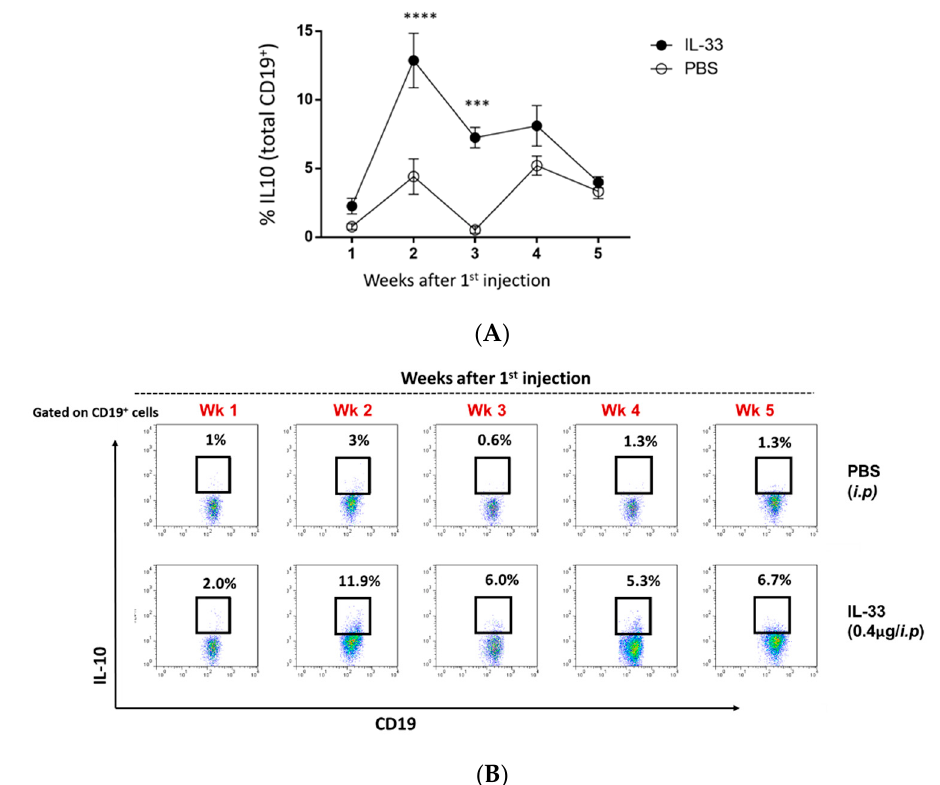
Figure 4. IL-33 increased the frequency of circulating IL-10 + regulatory B (Breg) cells in young NZB/F1 mice. Beginning at 6 weeks of age, NZB/W F1 mice were given peritoneal treatments of IL-33 or PBS, two times a week for five continuous weeks. Throughout the treatments, weekly blood samples were obtained and re-stimulated with PMA/ionomycin/brefeldin for the detection of IL-10-expressing CD19 + cells with flow cytometry. ( A ) Representative plots of IL-10 + Breg cells in the PBS- and IL-33-treated mice. ( B ) Comparison of the percentage of Breg cells. n = 12, bars represent the mean ± SEM. *** p < 0.001, **** p < 0.0001, two-way ANOVA with multiple comparisons were performed. Results represent three independent experiments.